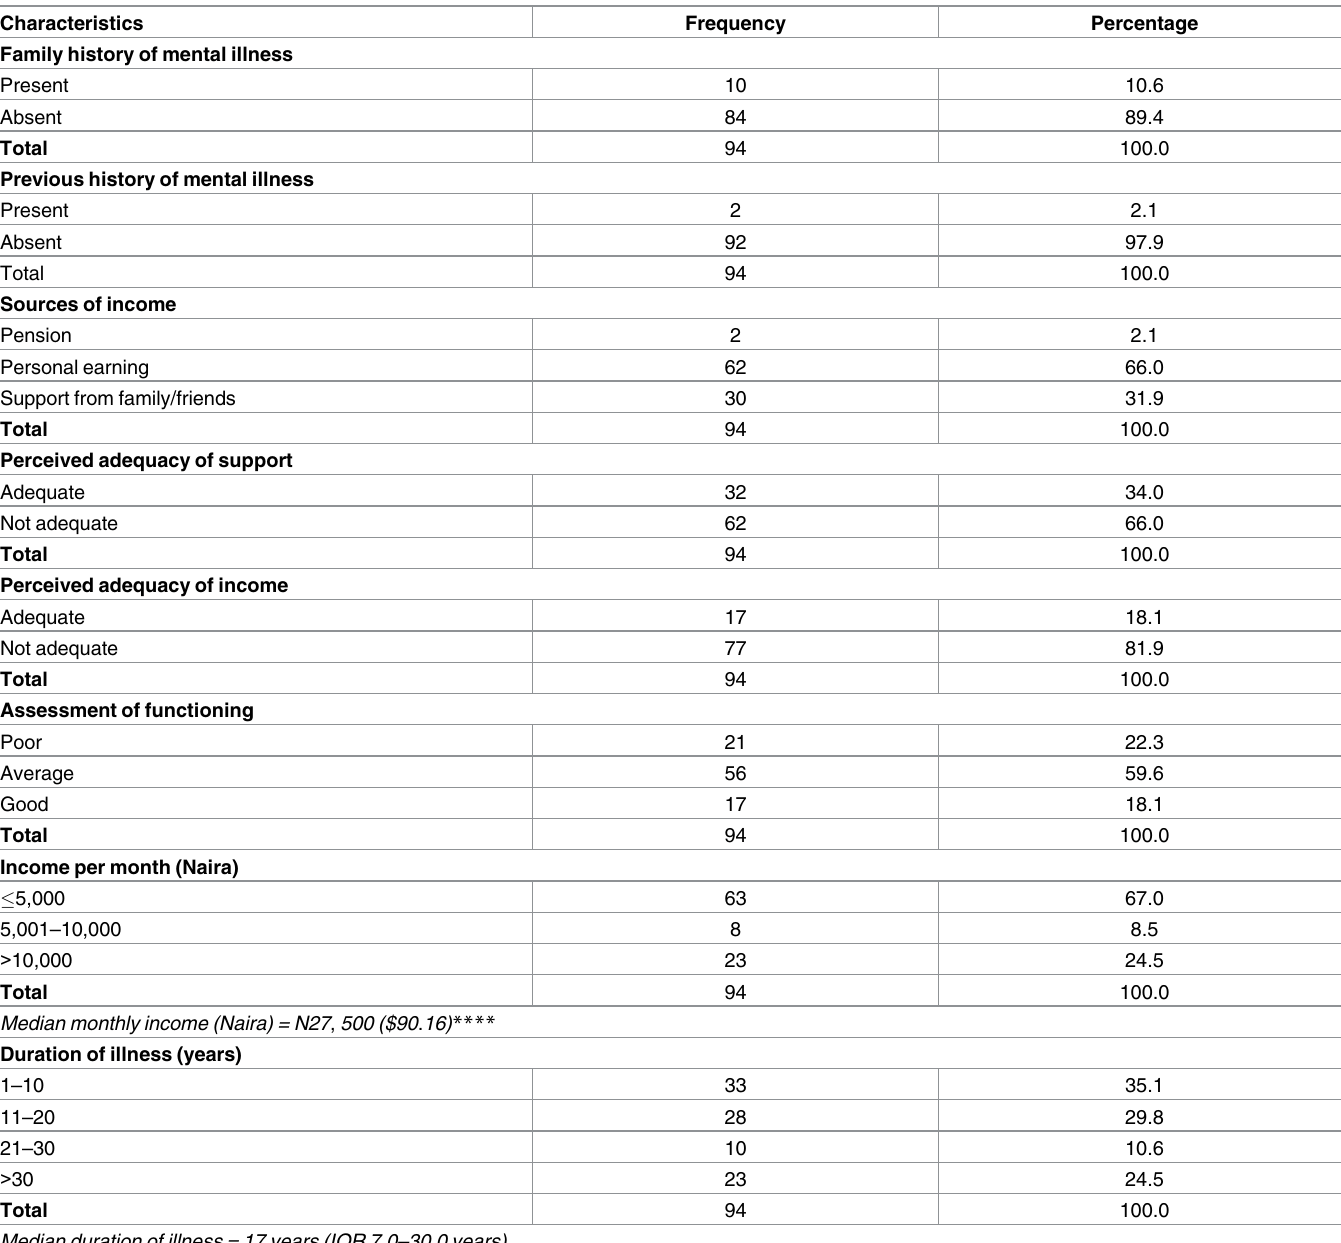
Table 2. History of mental illness, economic status, functioning and adequacy of support.